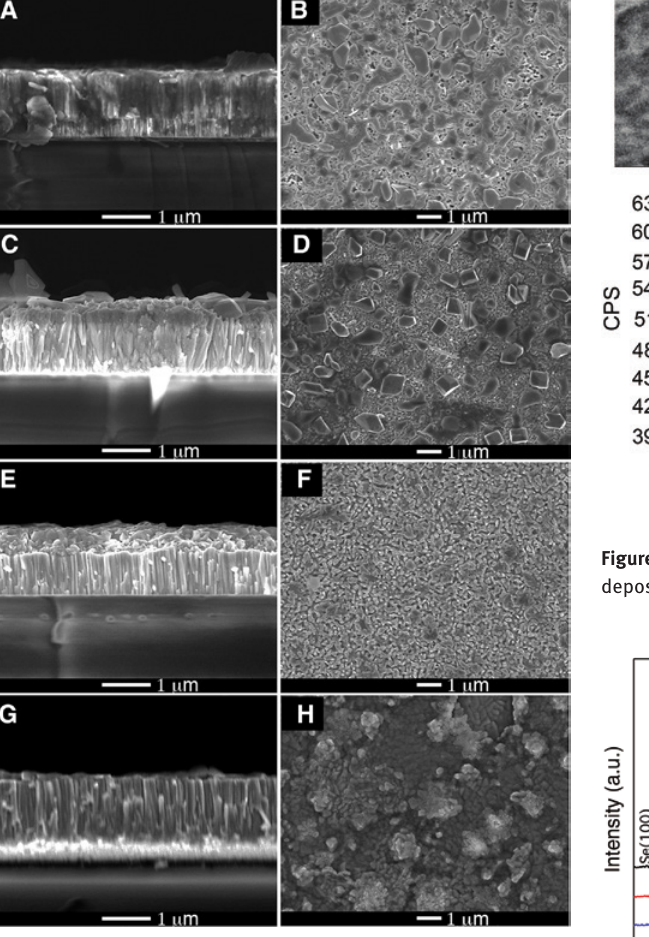
Figure 2: FE-SEM cross-section and surface images of single-layer Mo films deposited by DC-magnetron sputtering at different working pressures of 2 mTorr (A and B), 3 mTorr (C and D), 4 mTorr (E and F), and 5 mTorr (G and H) after selenization at 500°C for 20 min under ambient Se. FIgure 4: XRD pattern of single-layer Mo films deposited at various working pressures of (A) 2 mTorr, (B) 3 mTorr, (C) 4 mTorr, and (D) 5 mTorr after selenization at 500 ° C for 20 min under ambient Se.